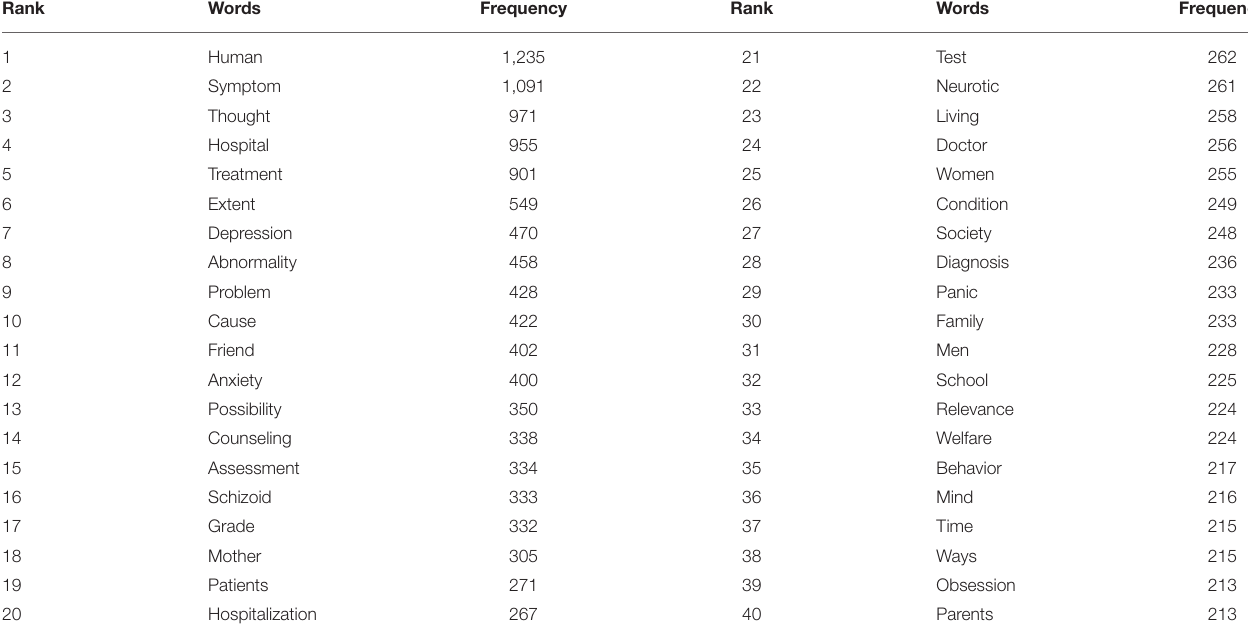
TABLE 1 | Frequencies of the top ranked